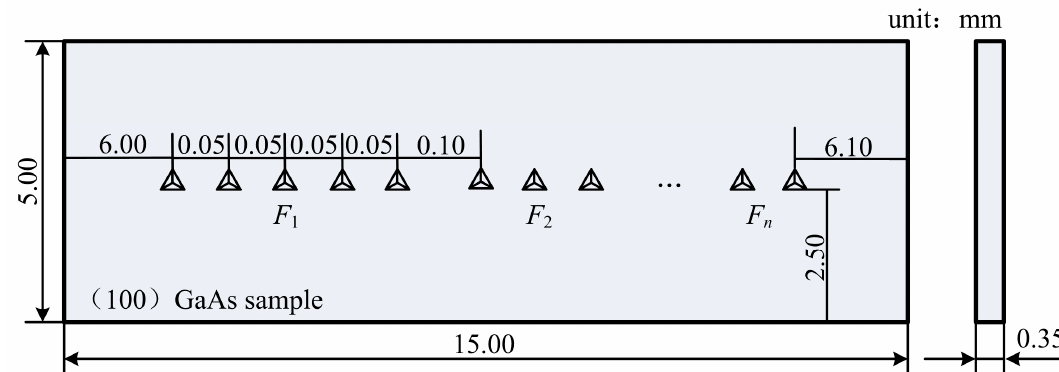
Figure 2. Schematic of the indent distribution on the GaAs sample (100) surface by Berkovich indenter (the size in the figure is not in scale). F i represents the indentation force. The size of the sample is 15.00 mm in length, 5.00 mm in width, and 0.35 mm in thickness. The indents are distributed along the mid-width line with the distances of about 2.50 mm and 6.00 mm away from the four edges of the sample. The distance between the indents under the same peak force is 0.05 mm, and the distance between the neighboring indents under different forces is 0.10 mm.